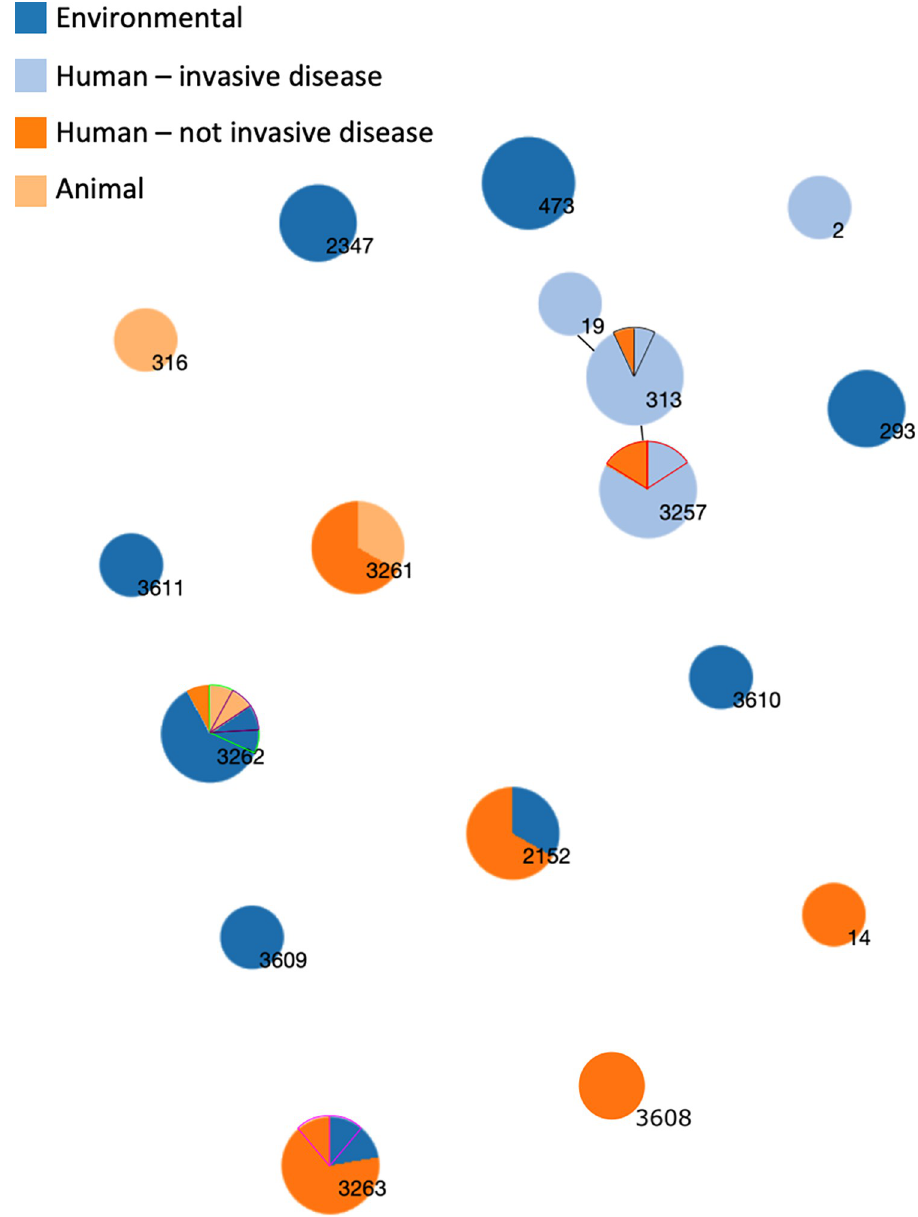
Fig 2. Minimum spanning tree based on seven MLST genes showing the genetic similarity between different niches–the only non-clinical niche where STs associated with human invasive disease were present was the gut of household contacts. Each circle represents a sequence type, the size of the circle is proportional to the number of isolates of that ST. STs that vary by one locus are joined by a black bar. Two invasive disease index isolates had a matched isolate from a healthy human sample of the same ST from the same household. These isolates are indicated by black and red outlines. In cases where there were multiple isolates of the same sequence type isolated from the same household, these “slices” of pie have had a border of the same colour. I.e. There were two isolates of ST3257 isolated from the same household, one from human invasive disease, and one from human nont invasive disease. Therefore, on the ST3257 pie, one slice of orange (not-invasive) and one slice of light blue (invasive) have been bordered in red.